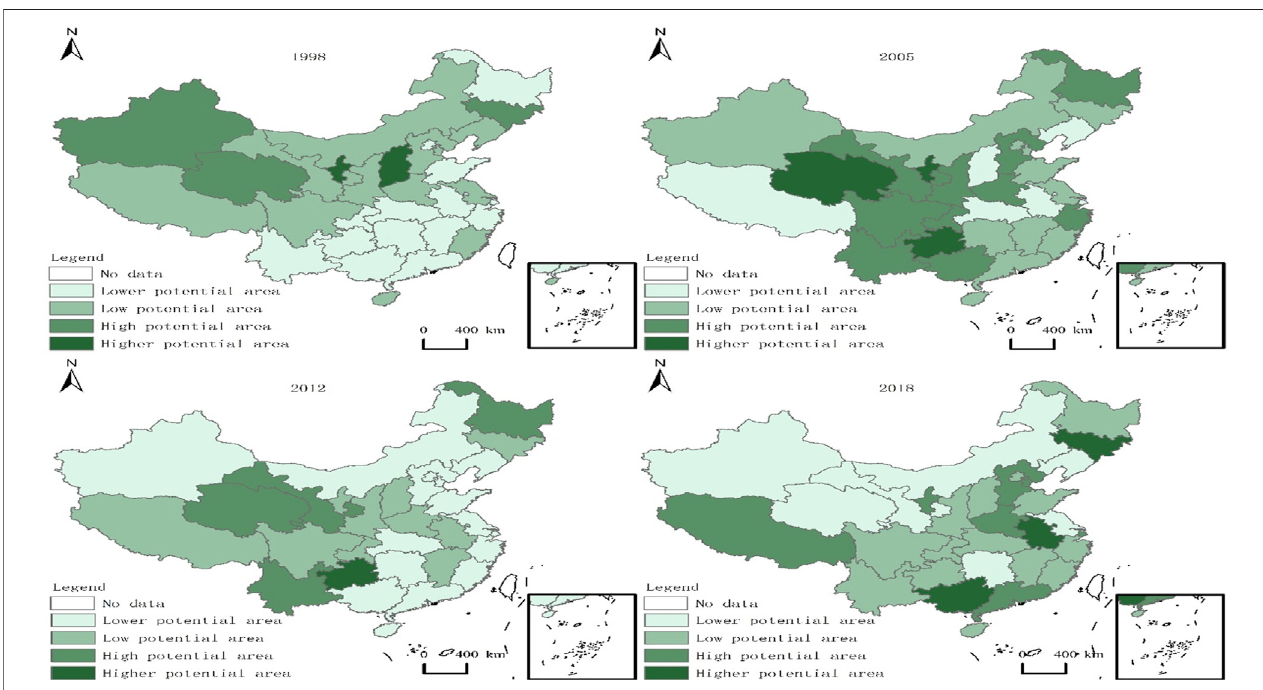
FIGURE 5 | The spatial distribution of the reduction potential of carbon emission of the agricultural green technological progress of China.